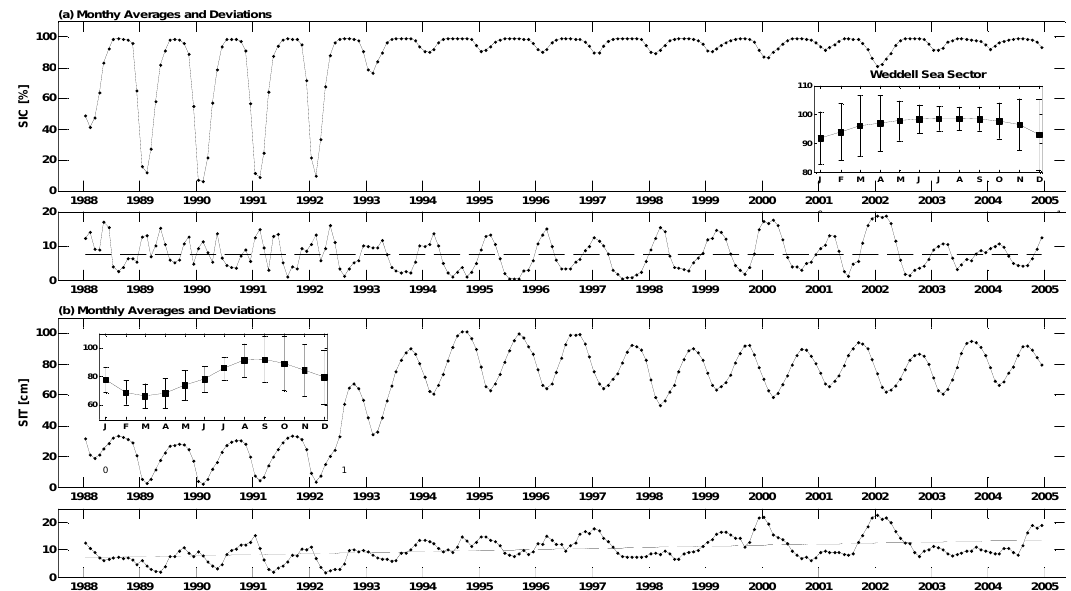
Fig. 13. OCCAM time series of monthly averages of (a) sea ice concentration (SIC) and (b) sea ice thickness (SIT) for the Weddell Sea sector from January 1988 through December 2004. The inset shows the annual cycle computed from the 17 years simulated. The lower panels in (a) and (b) show the monthly deviations of SIC and SIT, respectively, fitted with a linear least-squares best-fit trend